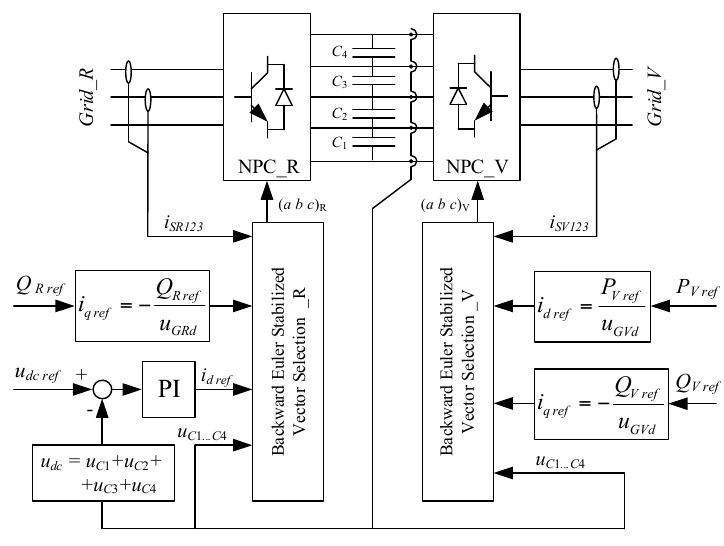
Figure 2. System control structure diagram.